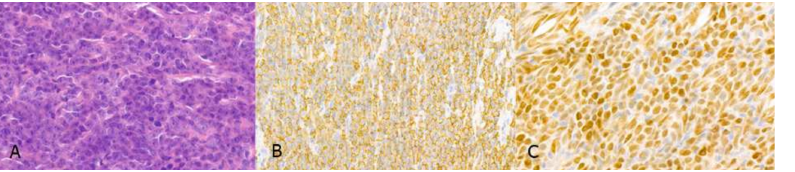
Figure 6. Histopathologic features of the tumor: ( A ) The maxillary tumor is composed of medium sized tumor cells with ovoid nuclei containing prominent central or multiple smaller nucleoli (H&E, 63 × ). ( B ) The tumor cells are homogenously positive with CD20 antibody (CD20/peroxidase, 40 × ). ( C ) 100% nuclear C-MYC expression is detected by immunohistochemistry (63 × ). By the time of the follow-up MRI, the tumor showed total regression in the region of the maxillary sinus. In both maxillary sinuses, concentric mucosal thickening was observed. The patient was monitored for two years without any relapse (Figure 7).